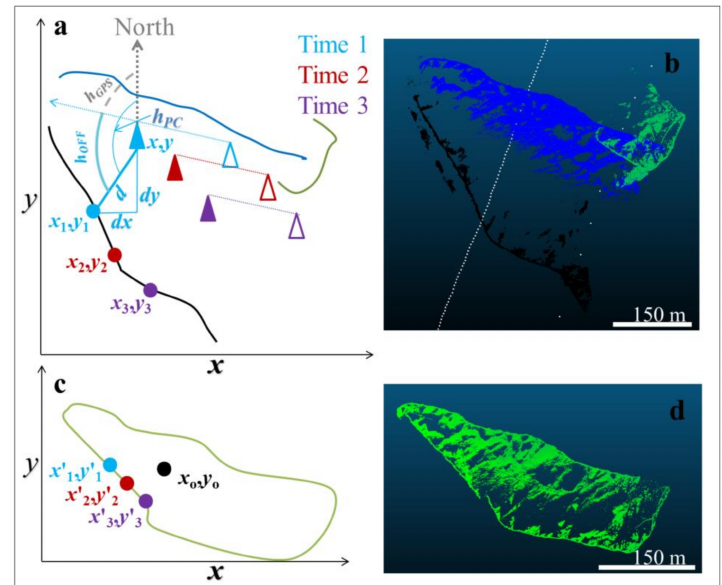
Figure 4. Example of the TLS point cloud drift correction procedure over three different survey segments. Panels ( a ) (schematic; segment 1: blue line, segment 2: green line, and segment 3: black line) and ( b ) (actual; segment 1: blue point cloud, segment 2: green point cloud and segment 3: black point cloud) show uncorrected point clouds. Panels ( c , d ) show the corrected version. The offsets used in the drift correction procedure are illustrated in panel a ; points (circles) collected at three time steps (denoted by subscripts and colours) were matched with two GPS positions (triangles) with the closest timestamps (illustrated with corresponding colours). The Euclidean distance ( d ) and heading ( h pc ) were found between cloud points with x and y coordinates and one of the GPS units (filled triangle). Theheading between both GPS units ( h GPS ) was also found at each time step. The offset heading ( h OFF ) is the difference between h pc and h GPS . d was calculated with the difference in x and y positions between the cloud point and the GPS unit (i.e., dx and dy ). Three example points and the positions of the two GPS units at the time that the point was collected are shown. Panel ( b ) shows the drift experienced by i1 during the survey with each survey segment along with white dots representing Solara FT2000 (left) and Canatec tracking beacon (right) locations. Point clouds were corrected ( c , d ) by reprojecting each point into the iceberg reference frame ( x ’, y ’) from a common set of coordinates ( x o , y o ) by using the relative distance and heading for each point found